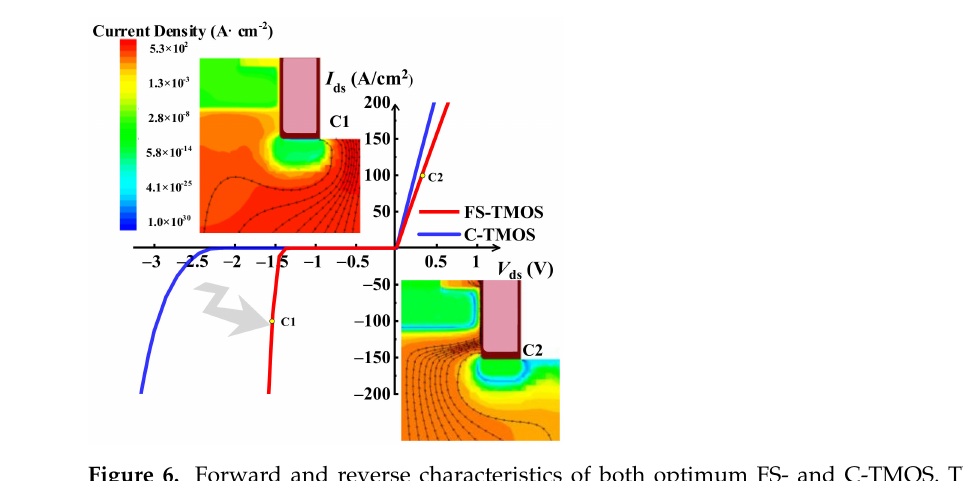
Figure 6. Forward and reverse characteristics of both optimum FS- and C-TMOS. The current distribution at the two key states C1 and C2 is presented as the inner figure.